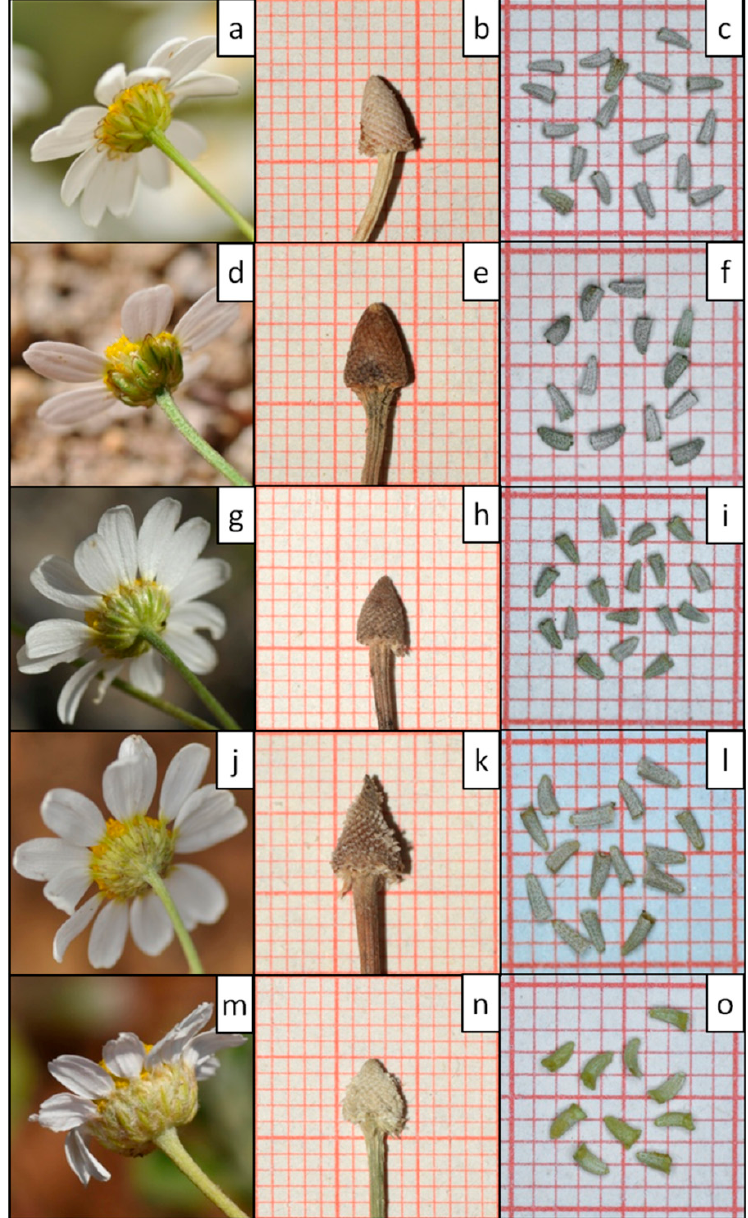
Figure 11. Comparative photographic material of the involucres ( a , d , g , j , m ), receptacles ( b , e , h , k , n ) and disc floret achenes ( c , f , i , l , o ) of the five taxa presented in this study: Anthemis macedonica subsp. macedonica ( a , b , c ), A. macedonica subsp. orbelica ( d , e , f ), A. meteorica ( g , h , i ), A. serpentinica ( j , k , l ) and A. thracica ( m , n , o ). Square sides = 1 mm. (Note: The d capitulum has an unusual low number of ray florets).